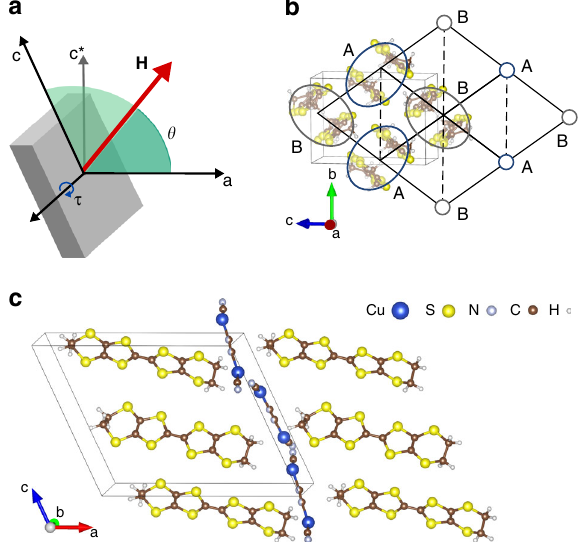
Fig. 1 Magnetic torque in the organic charge transfer salt κ -Cu. a De fi nition of quantities used in the expressions of the torque τ . θ is the angle between the magnetic fi eld H and the principle axis of the product of the uniform G T g -tensors, ð G , which is approximately the crystallographic a- axis. u (cid:2) u Þ b Anisotropic triangular lattice with the sublattices labeled A and B on top of the bisethyelenedithioltetrathiafulvalene (ET) dimers in κ -(ET) 2 Cu 2 (CN) 3 ( κ -Cu). c Crystal structure of κ -Cu, showing the organic layer of ET molecules and the anion